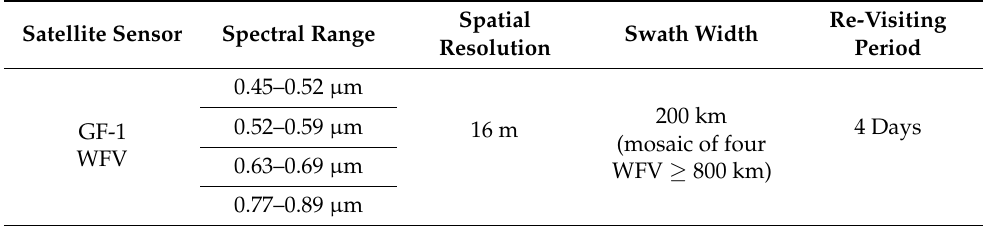
Table 1. Main techno-parameters of WFV cameras aboard on Gaofen-1 satellite. Satellite Sensor Spectral Range